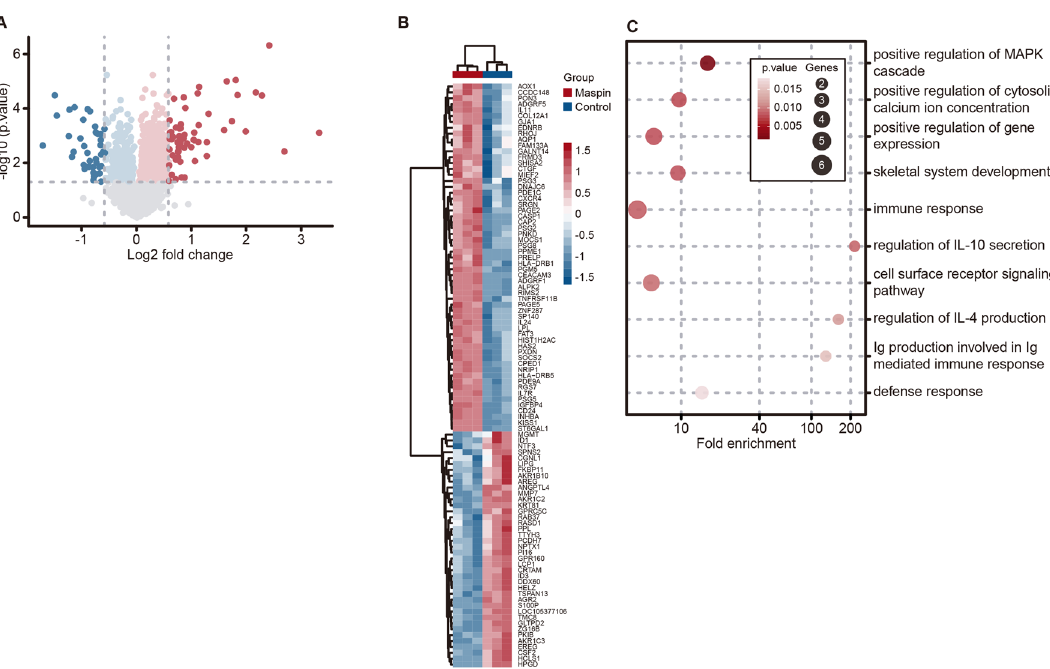
Figure 4. Analysis of the gene expression profile in MDA-MB-231 cells stably expressing maspin or control. ( A ) Comparison of mRNA expression profiles between MB-231-maspin and MB-231-control cells. Volcano plot shows expression levels upregulated (red dot), downregulated (blue dot), and unchanged (gray dot) in MB-231-maspin cells. The x-axis is log2 fold change of gene expression levels between to cell lines, and the y-axis is adjusted P -value based on -log10. Red and blue dots show the differentially expressed genes (DEGs) based on P < 0.05. Deep color represents 1.5-fold expression difference. ( B ) Heatmap and hierarchical clustering of the DEGs with > 1.5-fold change in MB-231-maspin cells. ( C ) Gene ontology (GO) enrichment analysis based on the DAVID biological process term. Bubble chart represents top-10 cluster enriched in a list of iDEGs. The x-axis is fold enrichment values, and the y-axis is the enrichment term. The size of bubble represents the number of DEGs. Transparency of the bubbles represents P -value. R (ver. 4.0.2, https:// www.r- proje ct. org) 23 and RStudio (Ver. 1.3.959, https:// rstud io. com) software were used to plot volcano plot, heatmap, and bubble chart. Tidyverse packages (ver. 1.3.0, https:// www. tidyv erse. org) 24 and pheatmap (ver. 1.0.12, https:// CRAN.R- proje ct. org/ packa ge= pheat map) 25 packages were used to run the